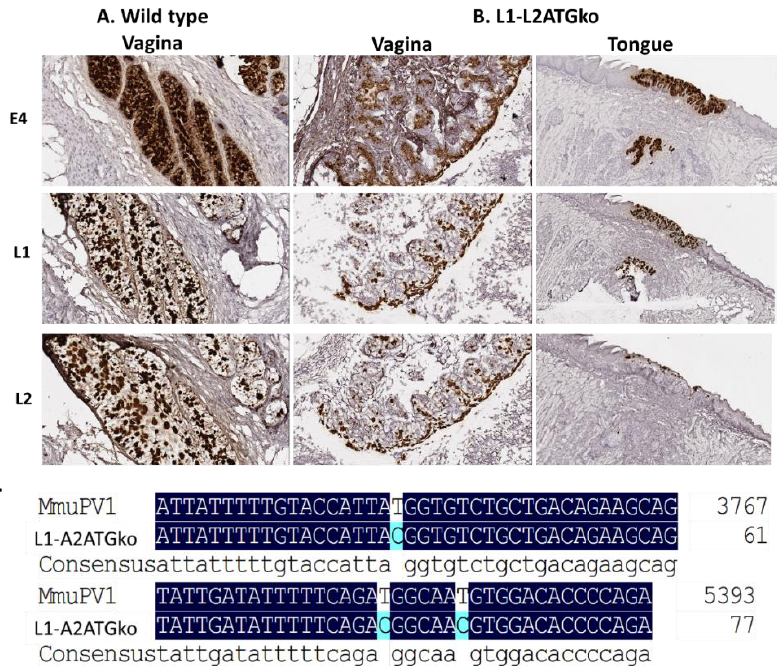
Figure 7. Viral transcripts (E4, L1, and L2) were detected in L1-L2ATGko infected tissues. Both wild- type ( A ) and L1-L2 mutant ( B ) infected tissues were examined for viral transcripts of E4, L1, and L2. All three transcripts (L1, L2, and E4) were found in both wild-type (Vaginal tissue) and L1-L2ATGko mutant (vaginal and tongue tissues). The mutation of L1-L2ATGko mutant was maintained in the lesions and confirmed by DNA sequencing following rolling circle amplification ( C ).